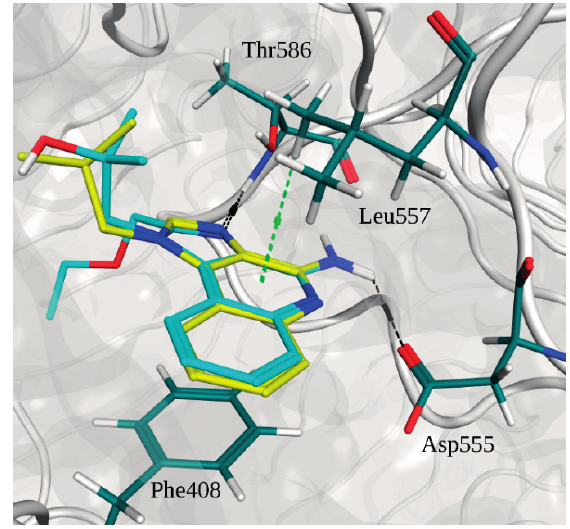
Figure 3. Superimposition of the binding poses of imidazoquinoline derivatives and main interactions with TLR7. R-837 carbons are depicted in yellow. R-848 carbons are depicted in cyan. Residue carbons are depicted in dark green. Nitrogens are depicted in blue. Polar hydrogens are depicted in white. Oxygens are depicted in red. Pocket surface is represented in gray. Hydrogen bonds are represented in black. C-H- π interactions are in light